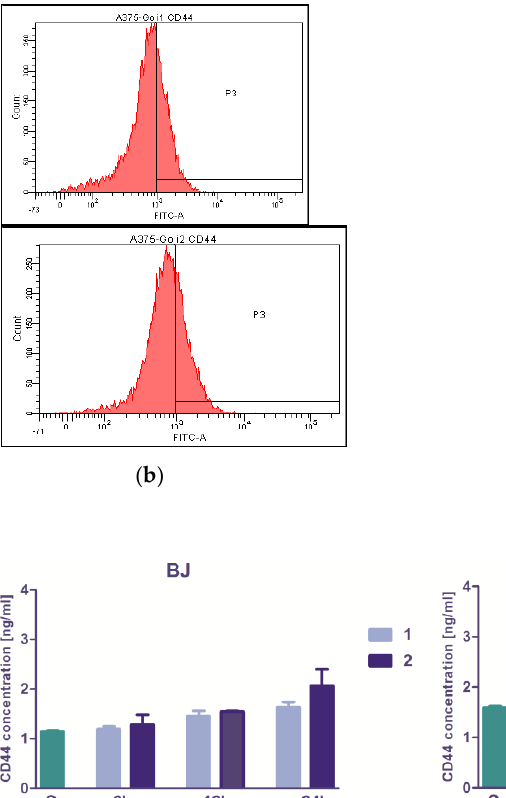
Figure 3. The modulation of CD44 membrane marker expression and the level of secreted CD44 protein in normal BJ versus A375 tumor cells treated with zeaxanthin-rich extract from Goji berries in vitro . The histograms represent the distribution of CD44-positive BJ cells ( a ) and CD44-positive A375 cells ( b ) in untreated control versus treatment with 50 μ M zeaxanthin-rich extract 1 and 2 , respectively. In the lower row ( c ): the level of secreted CD44 protein by the normal BJ and malignant A375 cells following the same treatments; the columns correspond to the untreated control C and zeaxanthin-rich extracts 1 and 2 . Table 3. Regulation of membrane- and intracellular marker expression in tumor and normal cells in vitro by the treatment with Goji-derived zeaxanthin 1 and 2